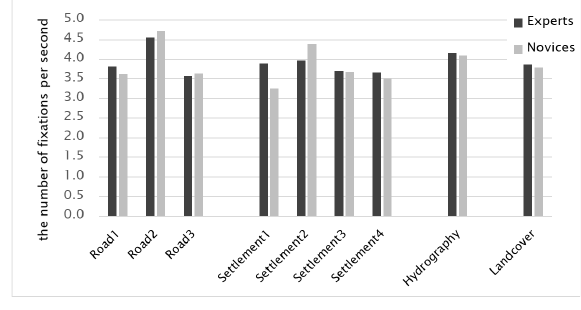
Figure 15. The number of fixations per second